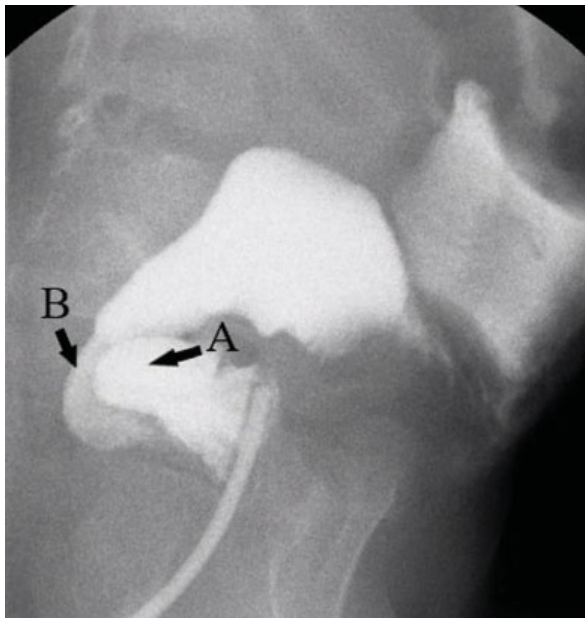
Fig. 2 Contrast enema study showing Duhamel spur. ( A ) Aganglionic pouch. ( B ) Ileum pull-through